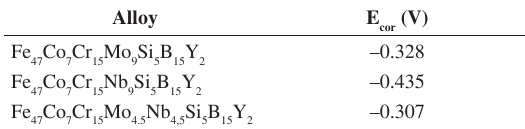
, of as cast alloys in 4M HCl solution. cor